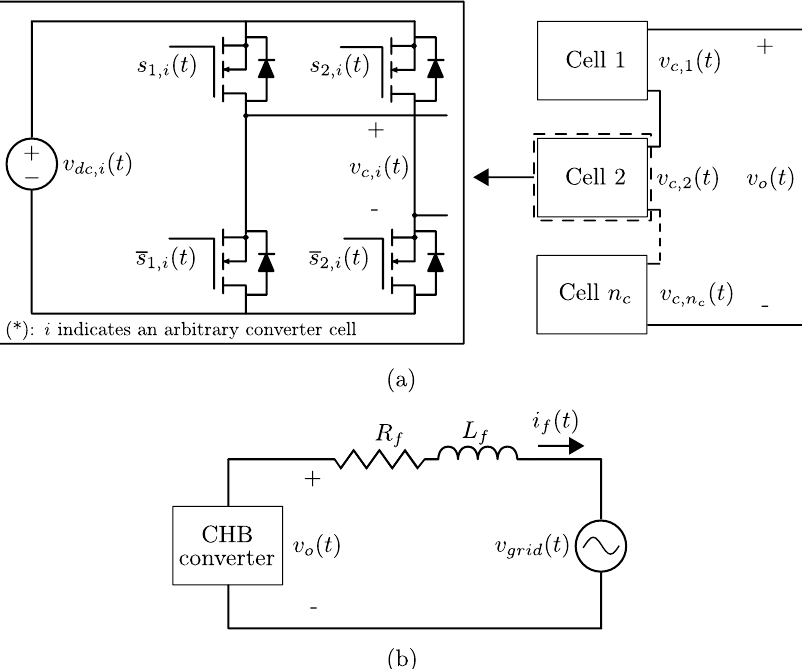
Figure 1. Cascade H-bridge converter. ( a ) standard topology; ( b ) grid connected single phase